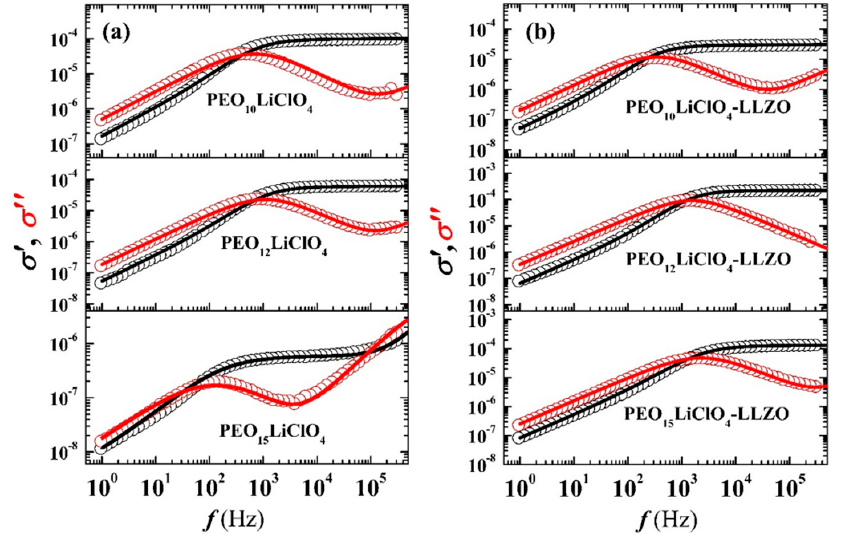
Figure 4. ( a ) Loss tangent of PEO n LiClO 4 and ( b ) PEO n LiClO 4 ‐ LLZO films. The open circles and solid lines represent the experimental data and the fitted data.